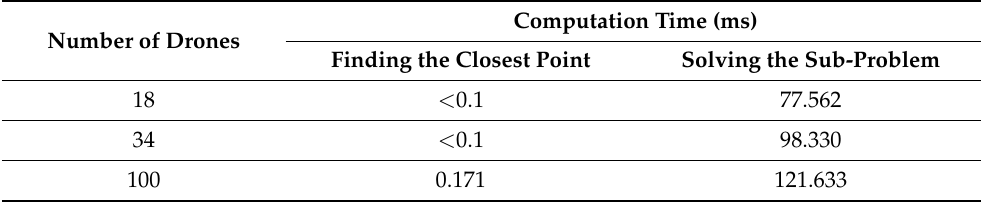
Table 2. Recorded computation times for finding the closest point in a Voronoi cell to the goal position and solving the optimization problem in simulation examples with 18, 34, and 100